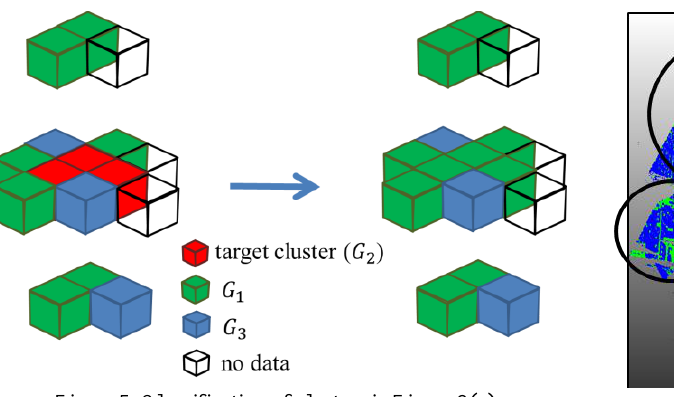
Figure 5. Classification of clusters in Figure 2(a).